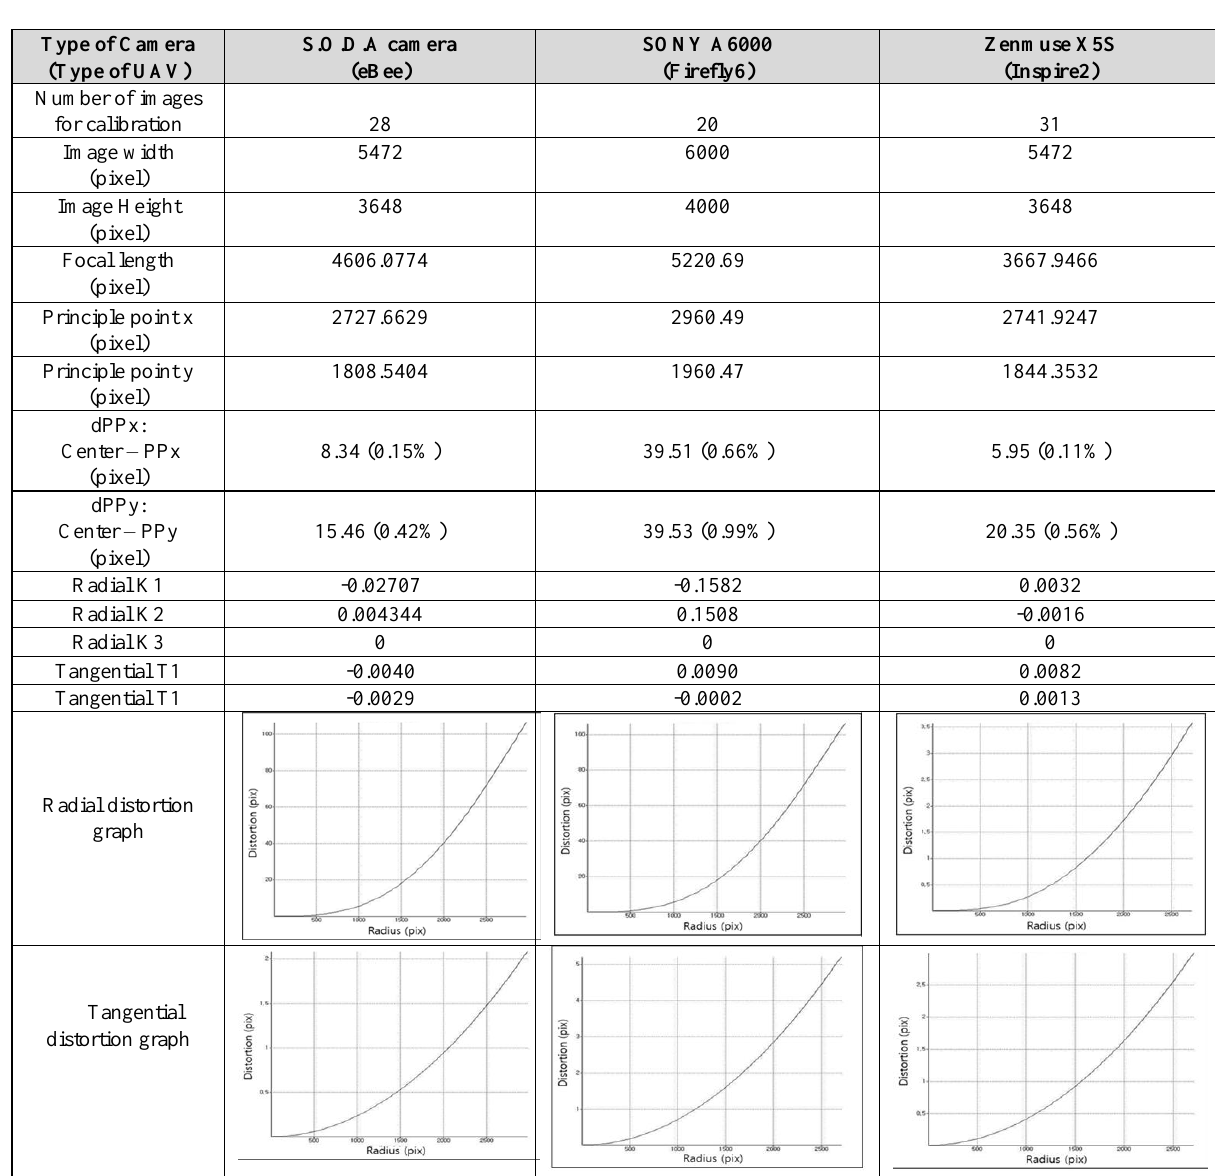
Table 3. Calibration result using using Camera Calibration Toolbox for Matlab